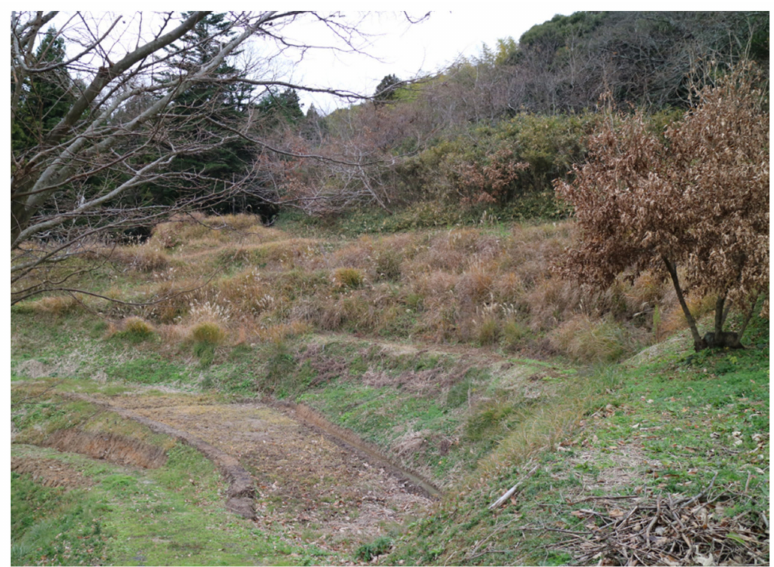
Figure 7. Habitat at the type locality of Hynobius kunibiki sp. nov. in Nishinomura, Kamionocho, Matsue City, Shimane